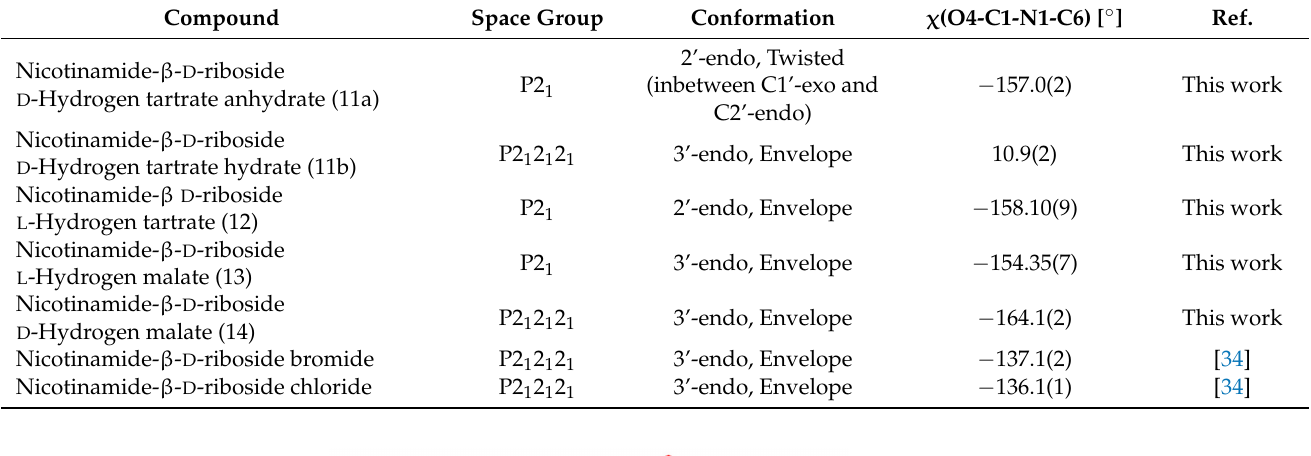
Table 4. Sugar conformation of different NR + derivatives.